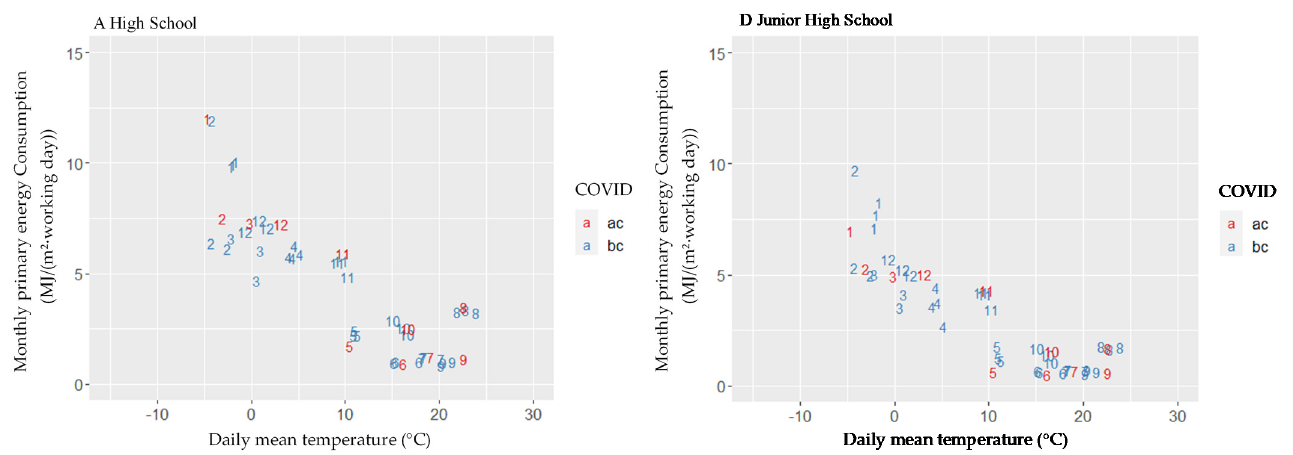
Figure 13. Relationship between monthly mean temperature and monthly primary energy consumption.